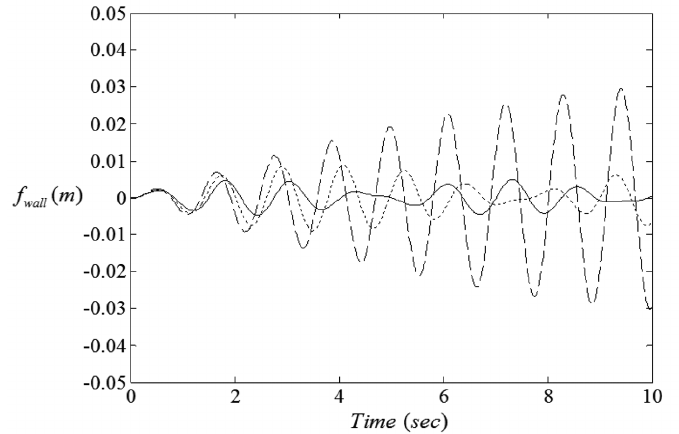
Fig. 4. Sloshing displacement at the container wall under the harmonic excitation for h 1 / R 2 = 0.3 and three different R 1 / R 2 ( R 1 / R 2 =